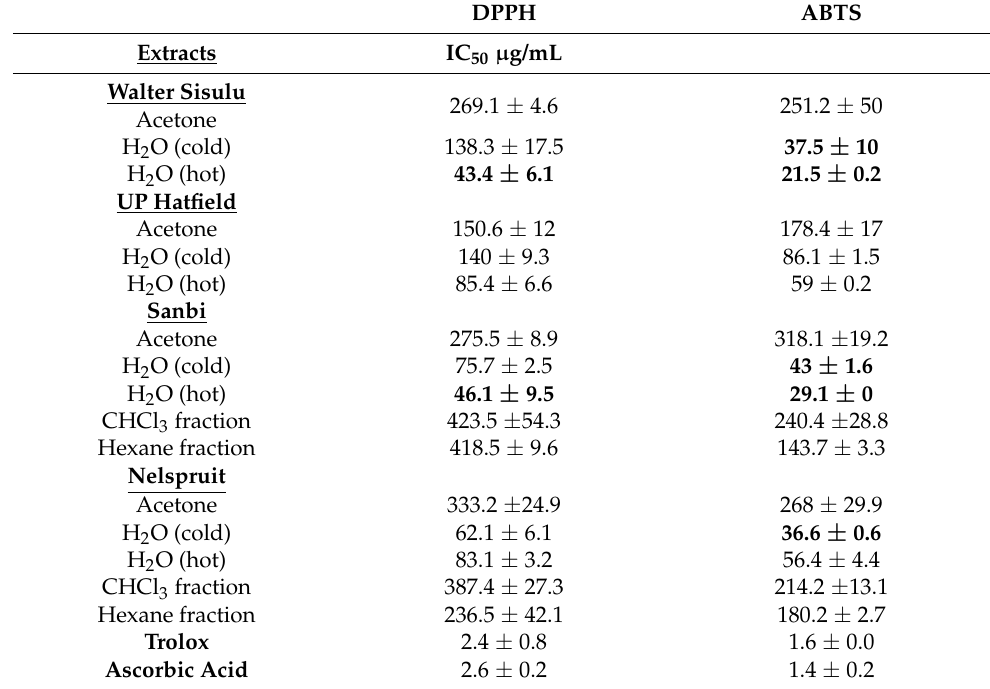
Table 2. Antioxidant activities (IC 50 µ g/mL) of the P. obliquum acetone extracts, aqueous extracts, and fractions. DPPH ABTS Extracts IC 50 µ g/mL 269.1 ±